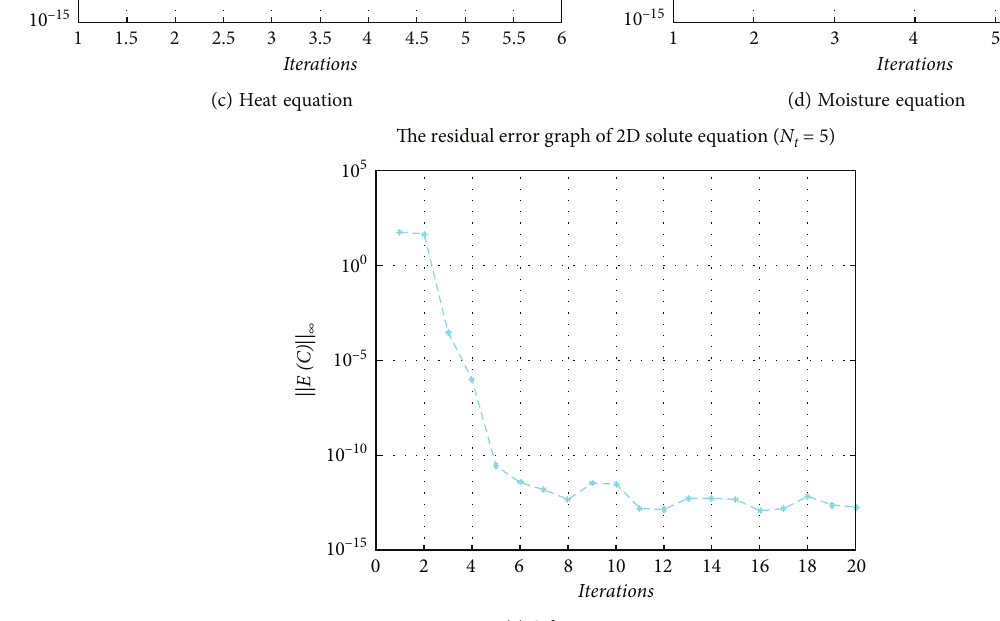
= N = 25 and N = 5 x z t